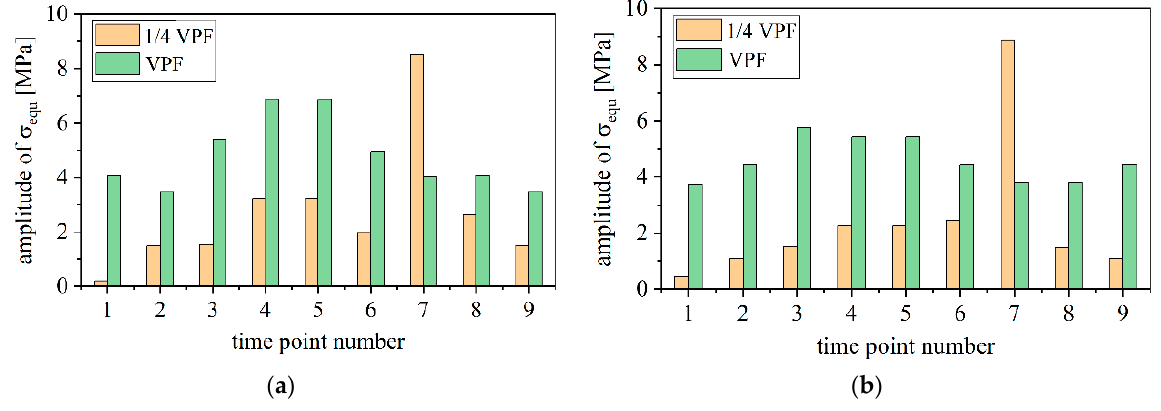
Figure 21. The peak ‐ to ‐ peak value of dynamic stress. Figure 22 shows the amplitudes of 1/4 VPF and VPF in start ‐ up process. At TP1, the frequency of dynamic stress while the amplitude of 1/4 VPF was almost zero. Later as the discharge and torque of runner increased, the amplitude of VPF rose slightly. The irregular flow in runner also became violent and led to an amplitude growth of 1/4 VPF. In second and third stage, the torque and discharge began to drop, but the influence of RSI continued, so the amplitude of VPF did not decrease. Moreover, there was a sudden rise of 1/4 VPF at TP7, and the amplitude fell rapidly at TP8. That was the reason for the maximum peak ‐ to ‐ peak value at TP7 in Figure 21.